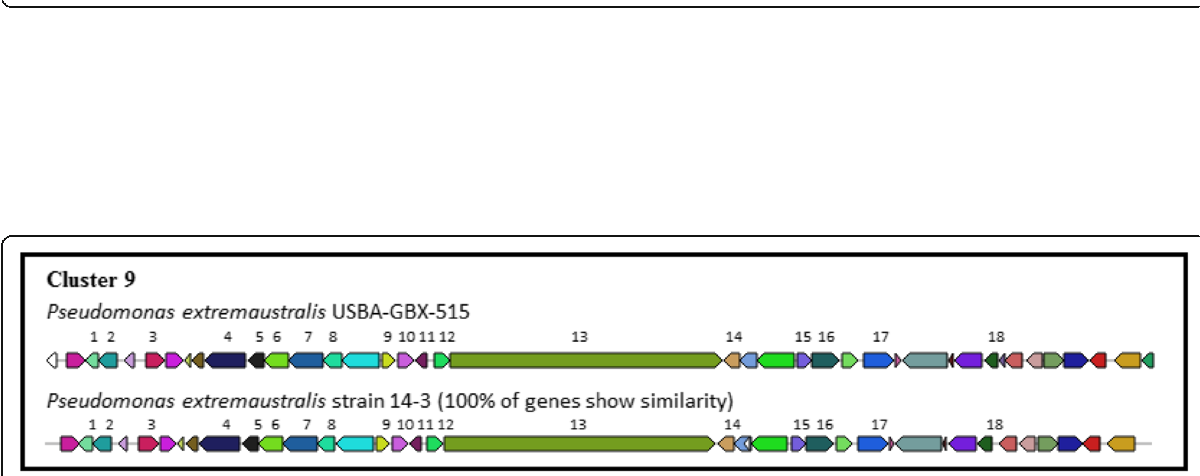
Fig. 11 Genetic map of Mangotoxin biosynthetic gene cluster 8 detected by AntiSMASH 3.0. The genes were designated by colors. Same color means equal genes in different strains; not colored means other genes. 1. ABC transporter permease; 2. ABC transporter ATP-binding protein; 3. hypo- thetical protein PA2310; 4. transcriptional regulator of proline and 4-hydroxyproline utilization HypR; 5. non-ribosomal peptide synthetase